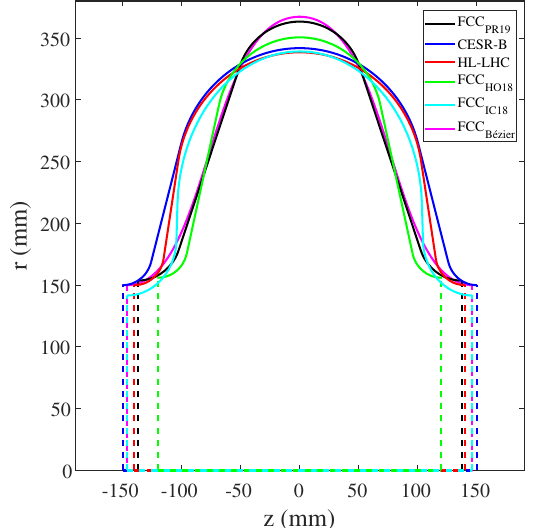
FIG. 11. A comparison of different cavity shapes from Table V. The details for the B´ezier cavity are given in Sec. VIII.